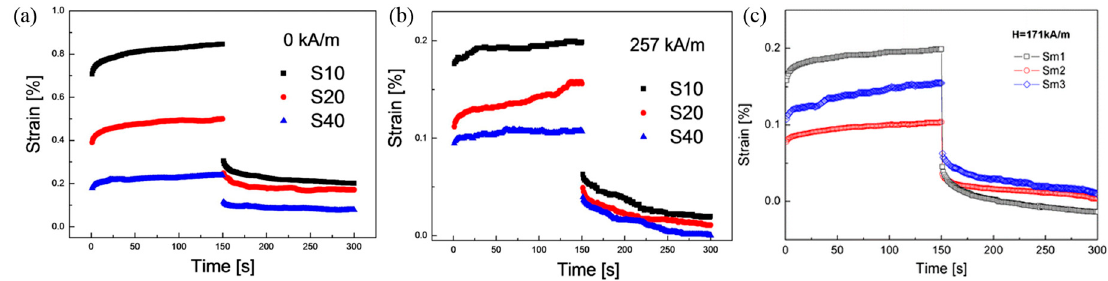
Figure9. CreepandrecoverycurvesofMREswithout( a )andwith( b )themagneticfield(H = 257kA / m)[131] Figure 9. Creep and recovery curves of MREs without ( a ) and with ( b ) the magnetic field (H = 257 ( c kA/m) [131] ( c ) creep and recovery curves of pure elastomer and the MRE samples with the stimuli of magnetic field [126].